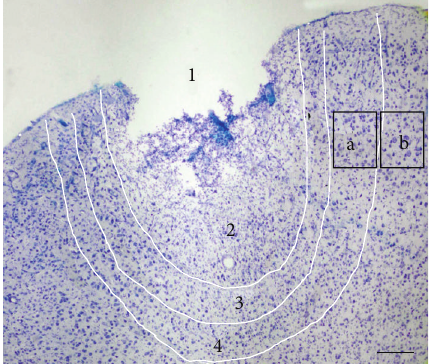
Figure 1: Location of lesion and perilesional zones of hemorrhagic stroke (S1FL field of cortex)—1: transplant (crumbled out), 2: infiltrate, 3: penumbra, 4: boundary zone. Rectangular areas of cortex from which tissue was taken for analysis—a: in the boundary zone; b: in the adjacent cortex. The scale bar is 300 𝜇 m.